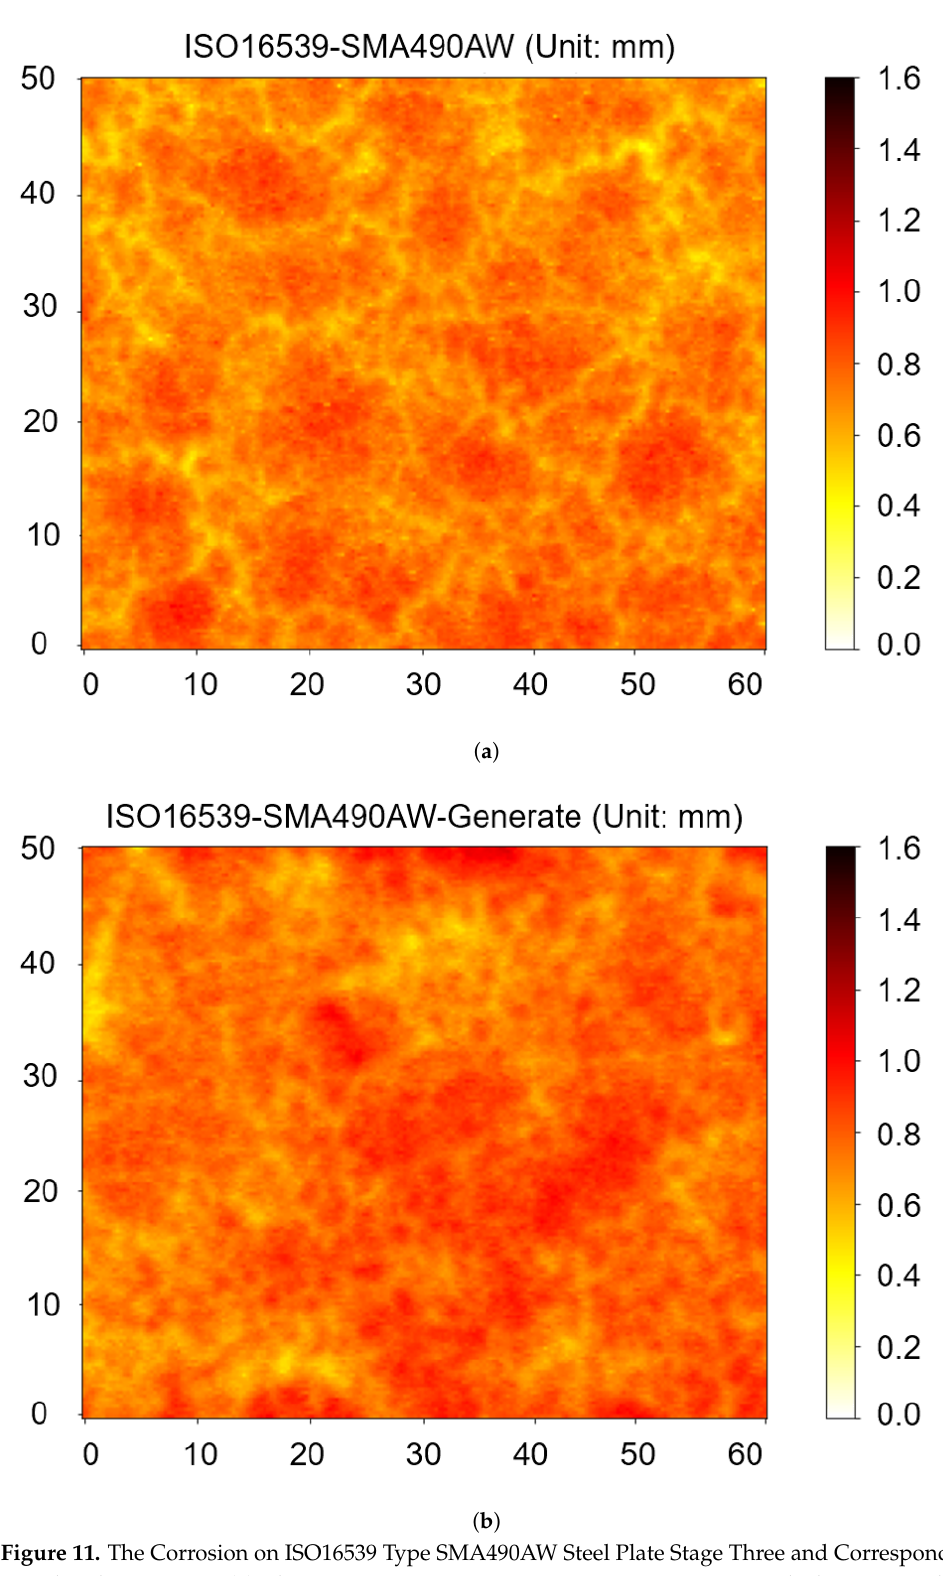
Figure 11. The Corrosion on ISO16539 Type SMA490AW Steel Plate Stage Three and Corresponding Simulated Corrosion; ( a ) The Corrosion on ISO16539 Type SMA490AW Steel Plate Stage Three; ( b ) The Corrosion on Simulated Type SMA490AW Steel Plate Stage